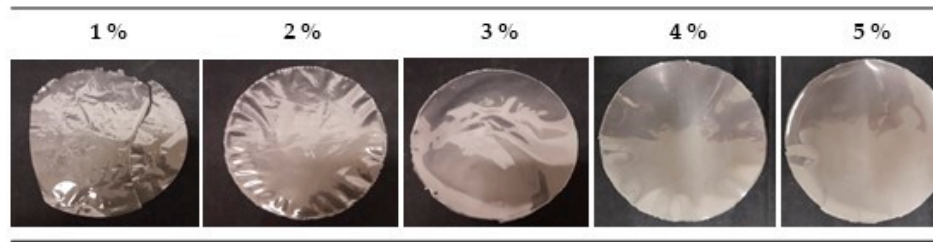
Figure 1. Images of the films with different concentrations of arrowroot starch in film-forming solution. Table 1. Thickness, water activity (Aw), moisture content, water in solubility and water vapor permeability values obtained for films produced with different concentrations of arrowroot starch in film-forming solution.